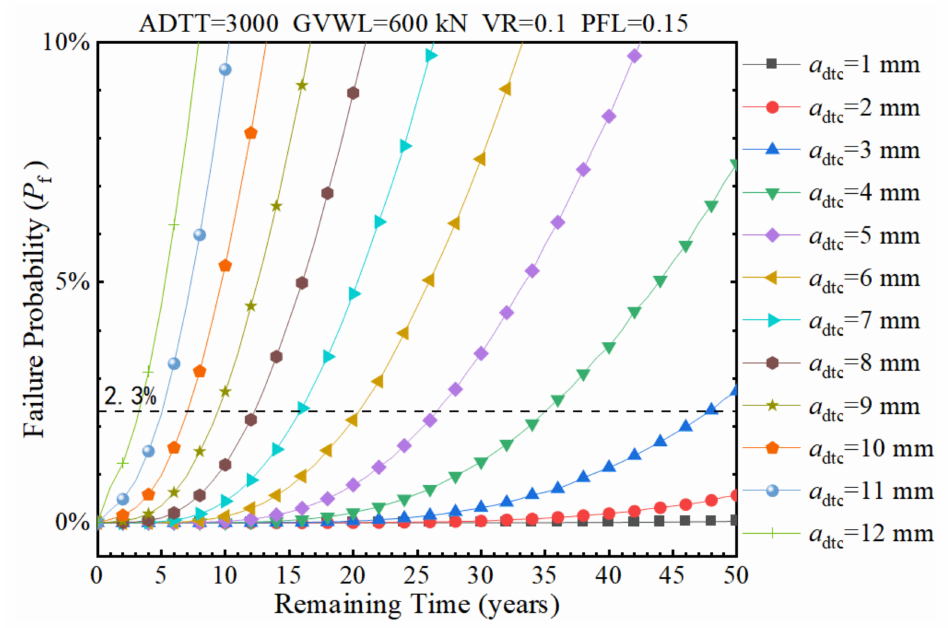
Figure 21. The failure probability of the fatigue detail under various detected crack sizes.